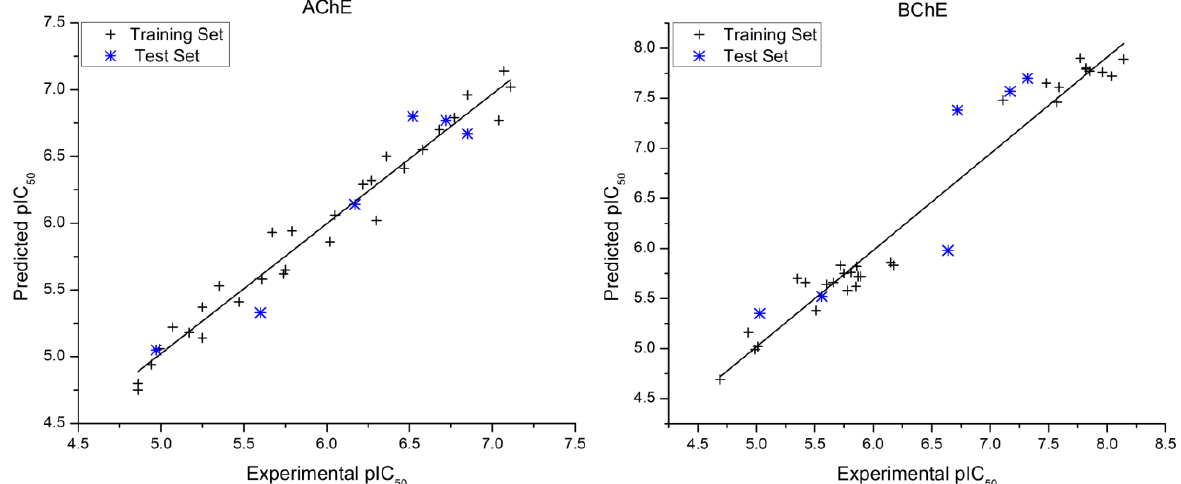
Figure 1. Plot of experimental versus predicted pIC the AChE and BChE inhibitors.